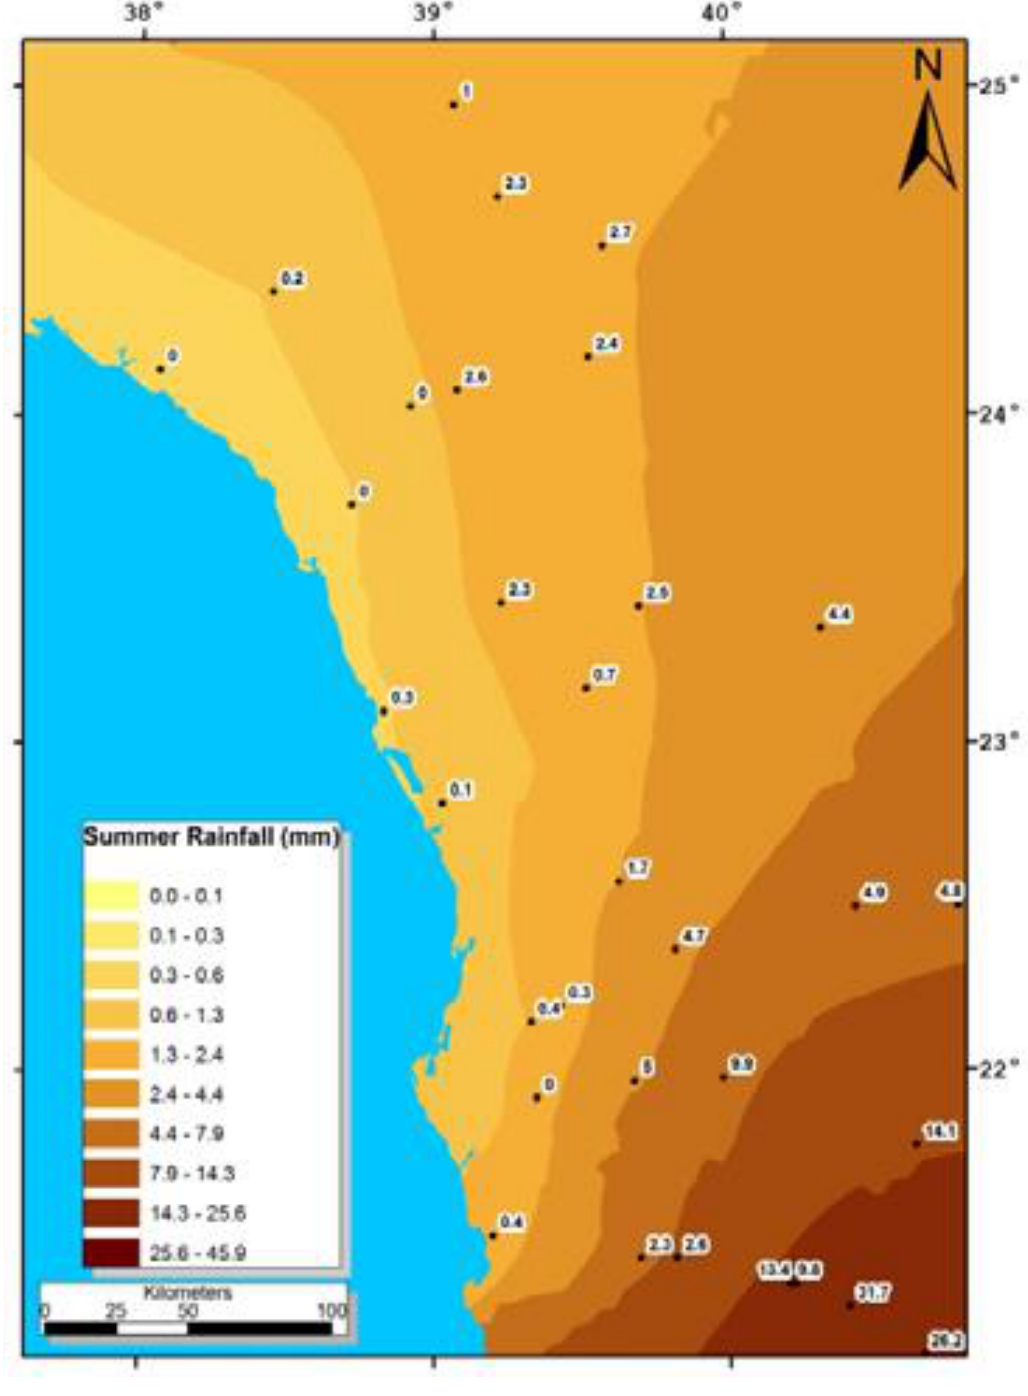
Figure 12. Isohyetal map for summer rainfall